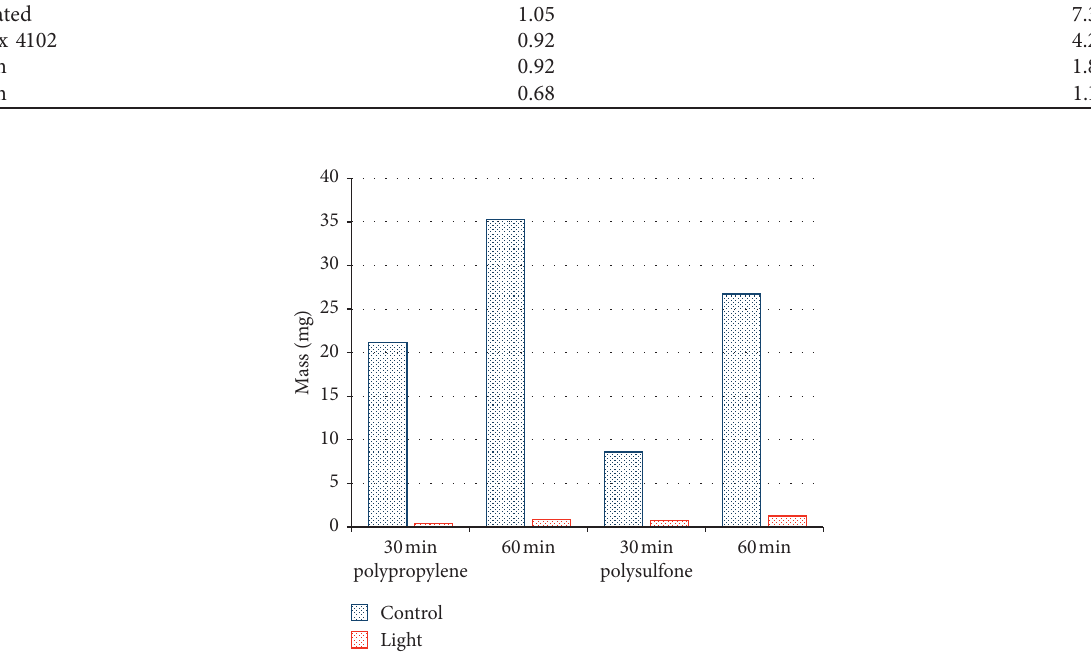
Figure 6: Weight measurements of calcium carbonate deposits with and without UV light treatment.